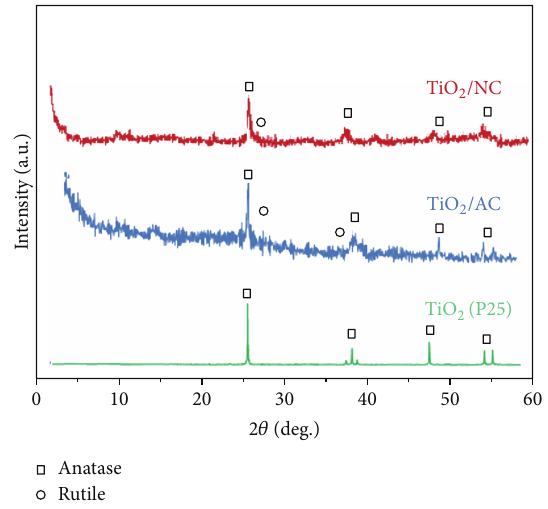
Figure 3: XRD patterns of TiO 2 /NC, TiO 2 /NC, and TiO 2 (P25).